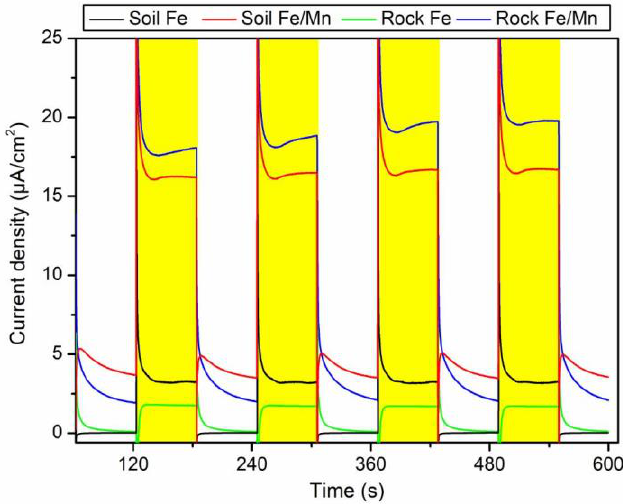
Figure 11. Photocurrent–time behavior of the soil Fe coating, soil Fe / Mn coating, rock Fe coating and rock Fe / Mn coating electrodes. The yellow regions indicate when the light is turned on.